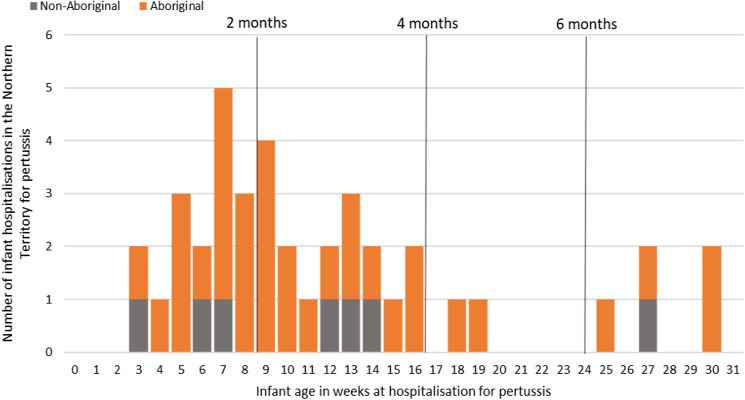
Number of pertussis hospitalisations in 0–<7 month old infants, by age in weeks of infant at time of hospitalisation and recommended pertussis vaccination schedule, Northern Territory, Australia (2000–2014).